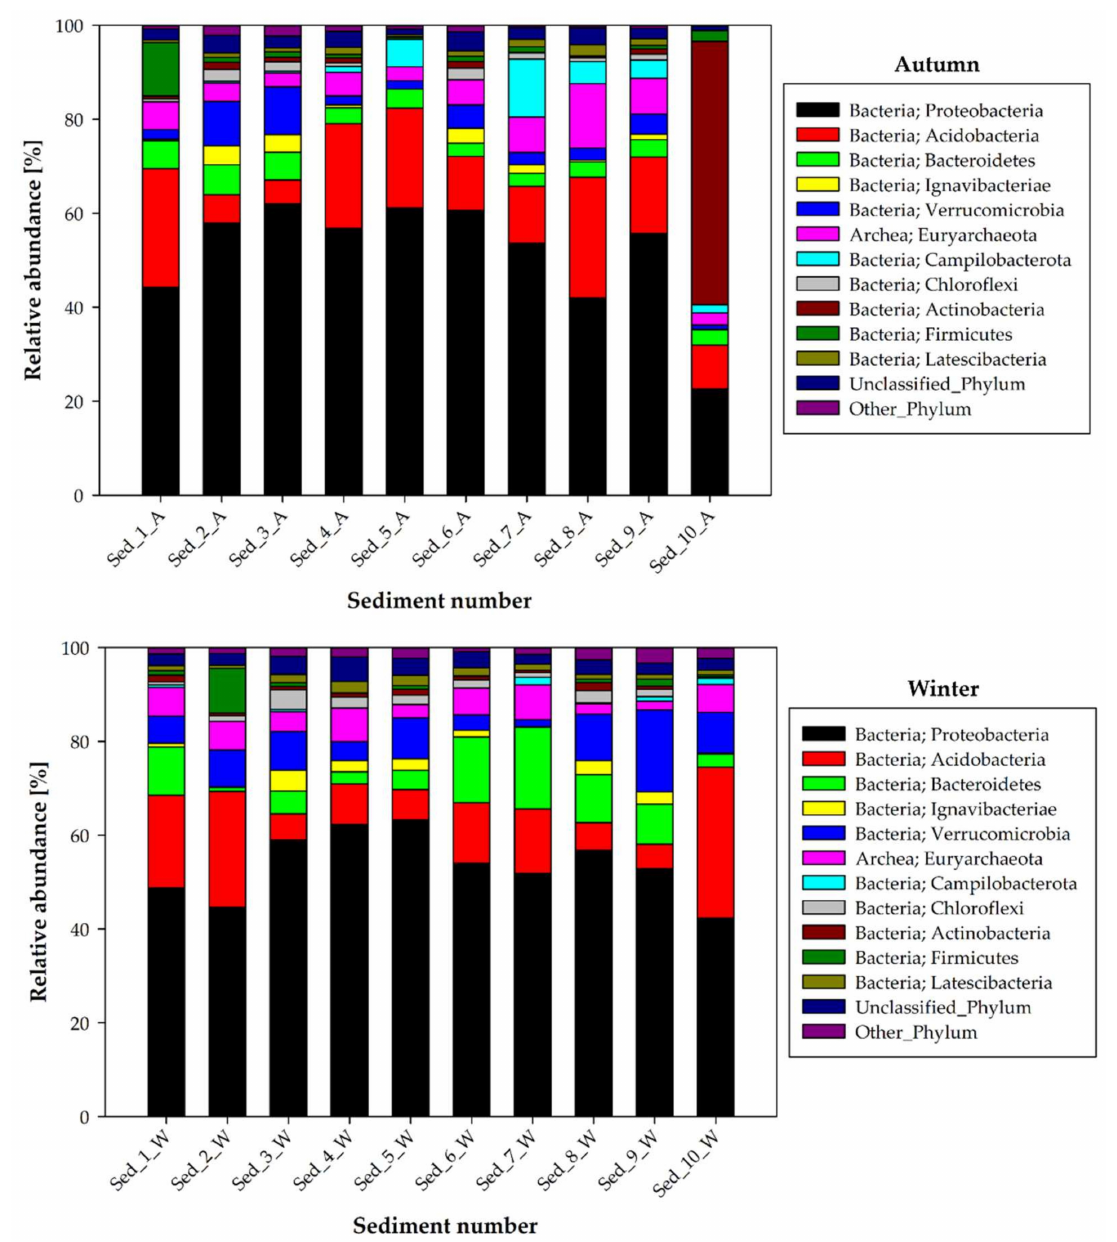
Figure 3. Seasonal changes in the phyla of bacteria in the selected locations of bottom sediment sam- pling in Cardinal Pond (1–10 Sed—sediment sampling points; Sp—spring, Su—summer, A—autumn,